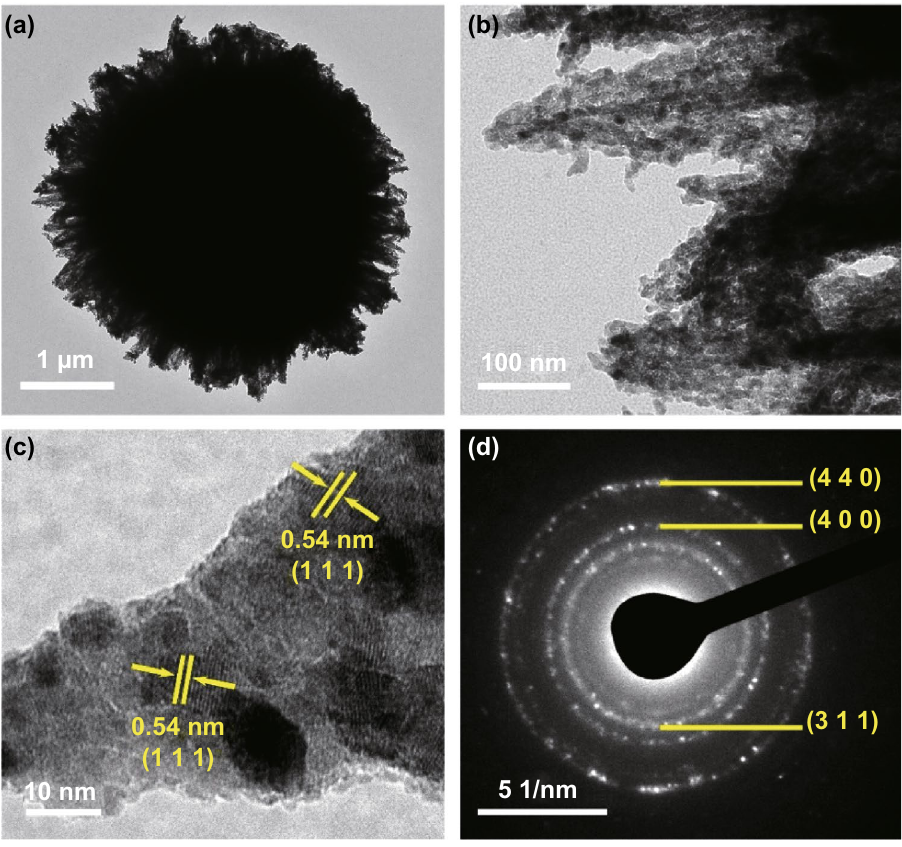
Fig. 3 TEM images of a an individual NCS@MCMB sphere and b NCS nanoneedles anchored on it. c HRTEM image of NCS nanoneedles and d corresponding SAED